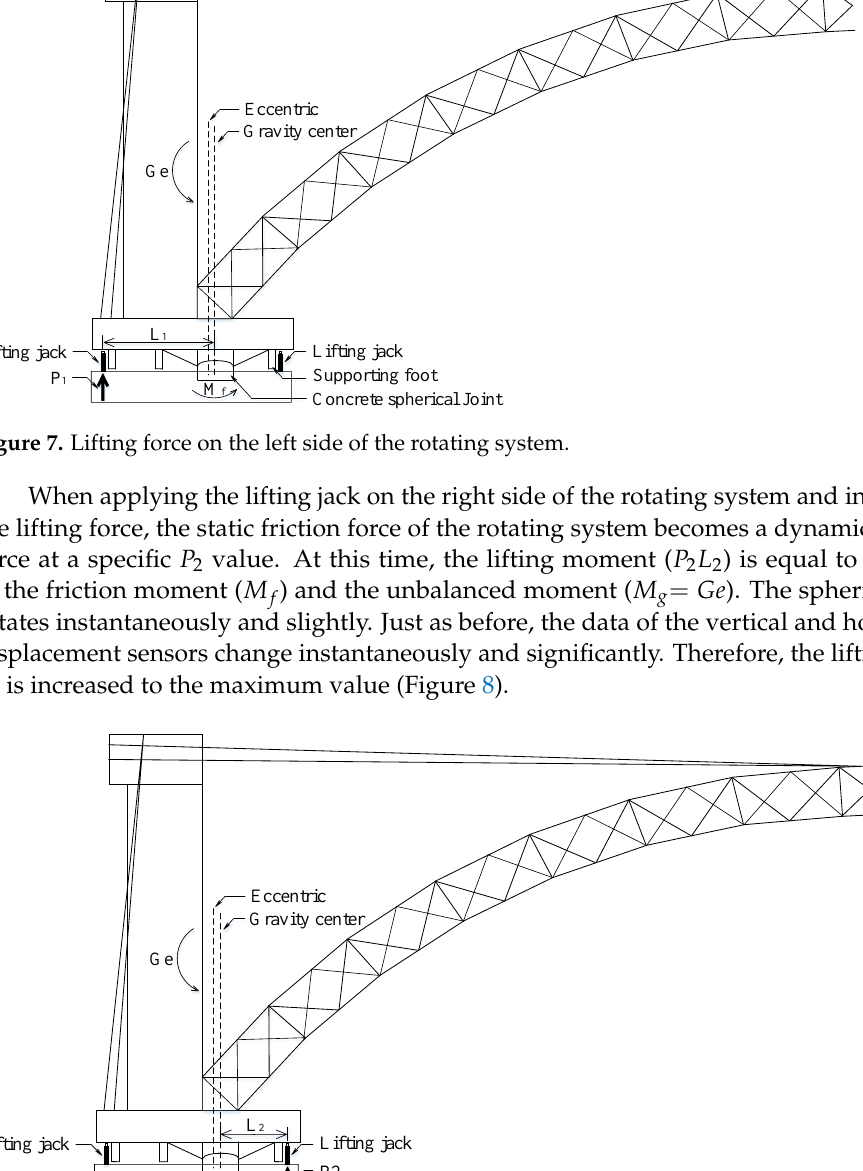
where P 2 is the lifting force of the spherical joint rotated instantaneously on the right side of the rotating system, and L 2 is the arm of the lifting force.